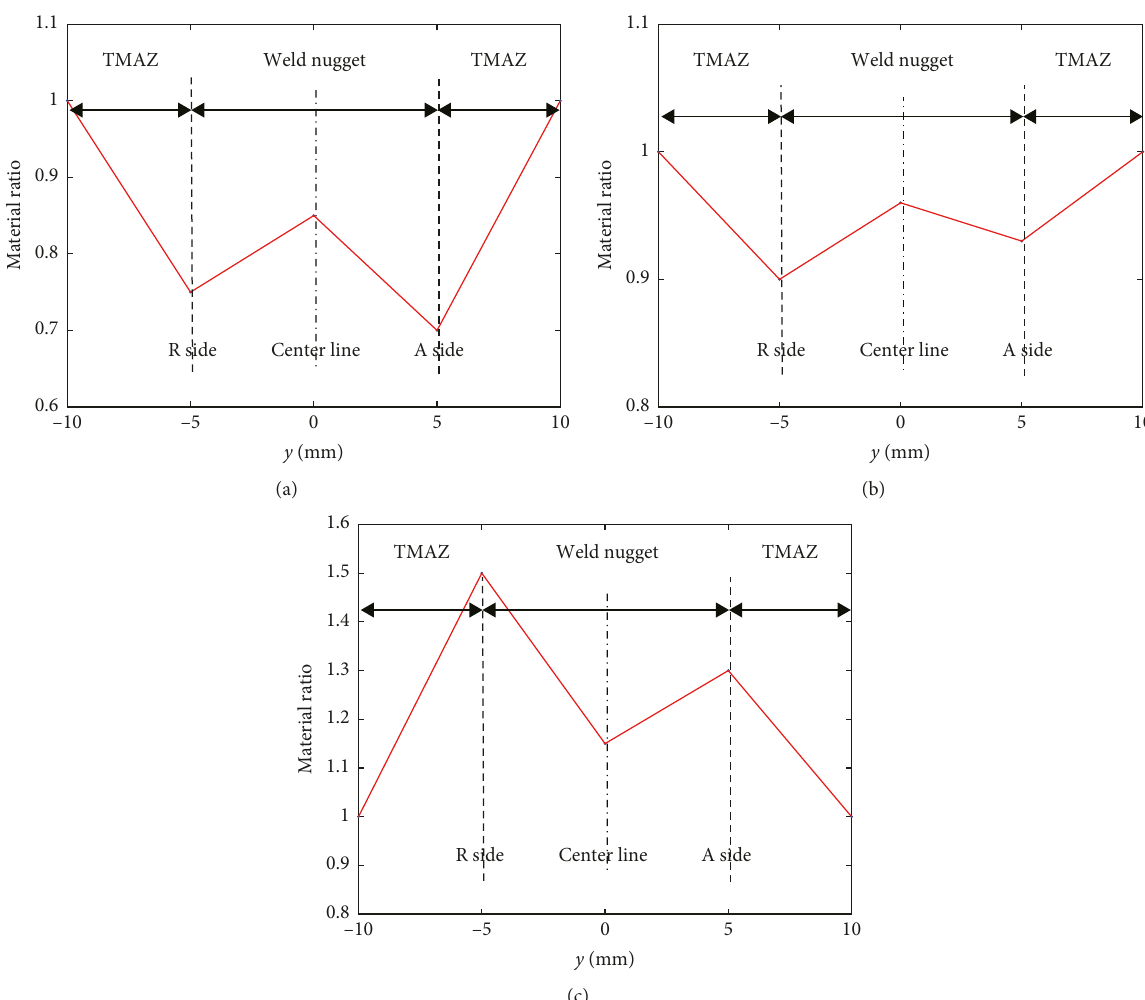
Figure 5: Material ratios of weld zones to base metal. (a) c , s